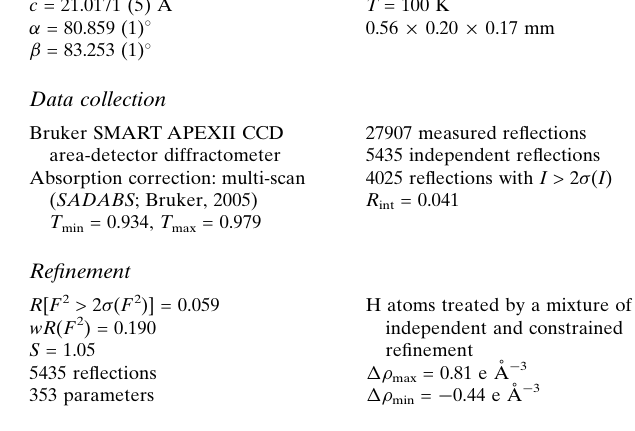
Bruker SMART APEXII CCD area-detector diffractometer Absorption correction: multi-scan ( SADABS ; Bruker, 2005)